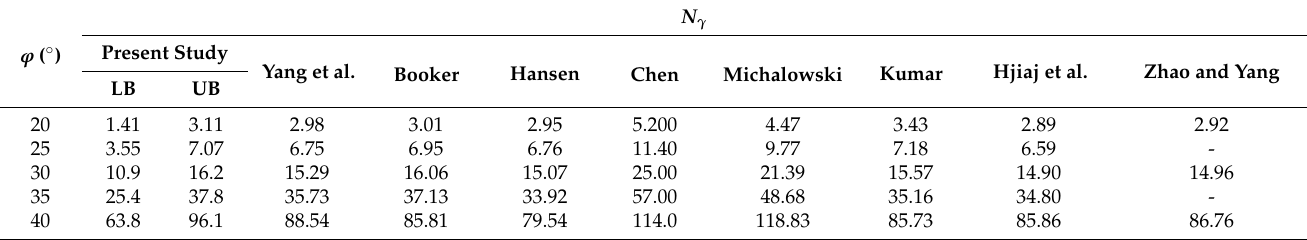
Table 3. Bearing capacity of the foundation: comparison with literature data, in terms of the capacity factor N c for a strip footing above a single void. D α